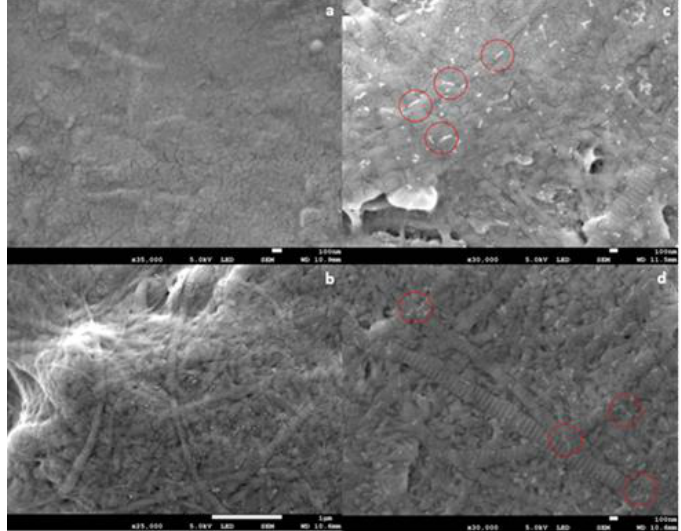
Figure 1. Scanning electron microscope (SEM) images of collagen fibril coatings on Ti6Al4V. ( a ) Bare Ti6Al4V; ( b ) collagen coating; ( c ) collagen + GY875 derivative coating; ( d ) collagen + HE800 derivative coating. Scale bars: ( a ) 100 nm; ( b ) 100 nm; ( c ) 1 µ m; ( d ) 100 nm. Representative white “threads” on ( c , d ) have been indicated by the red circles.